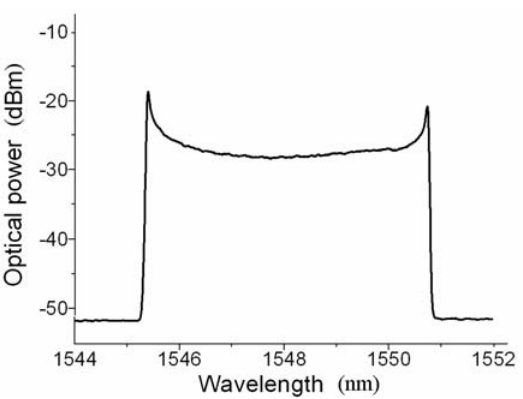
Figure 4. Experimentally measured optical spectrum of the FDML fiber